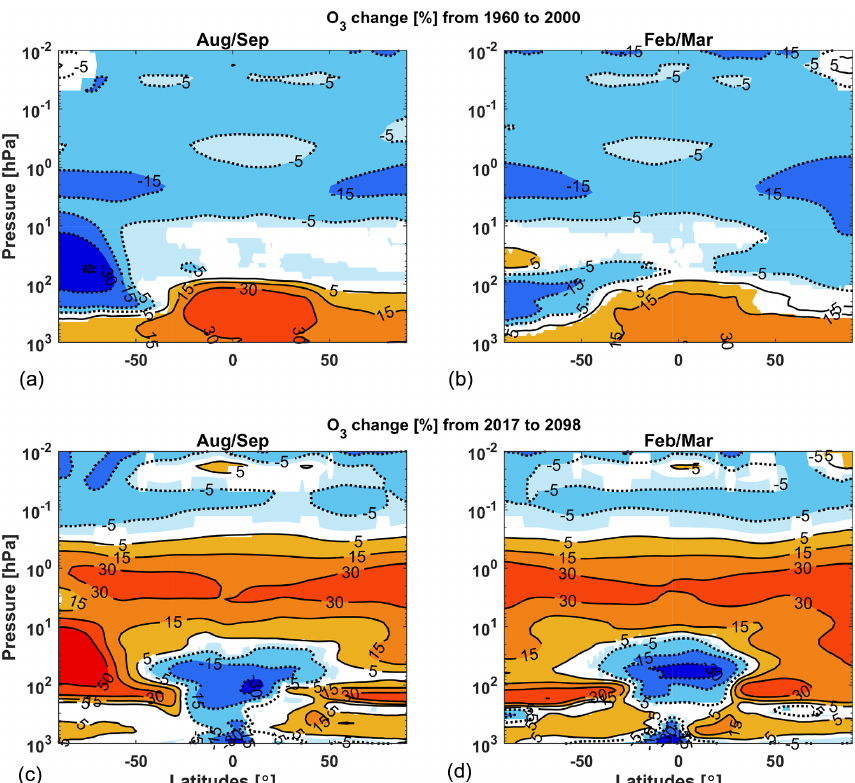
Figure 4. Relative change of ozone from 1960 to 2000 in the historical simulation ( a August/September, b February/March) and from 2017 to 2098 in SSP5 ( c August/September, d February/March). Positive contour levels are 5%, 15%, 30% and 50% (solid lines) and negative contour levels − 5%, − 15%, − 30% and − 50% (dotted lines). Colour shading indicates areas significant at the 95% level calculated with a Mann–Kendall test and a false detection